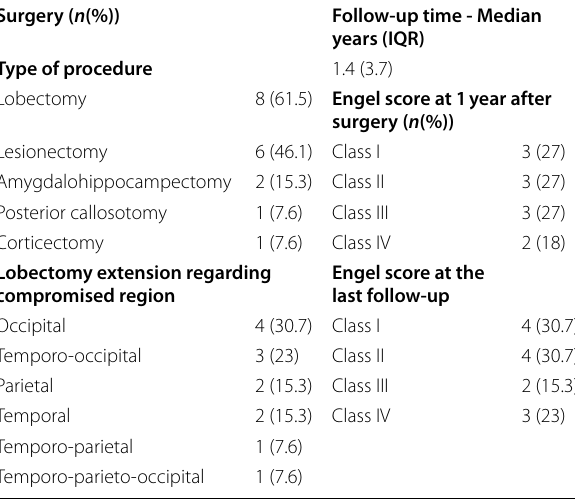
Table 4 Surgery type and